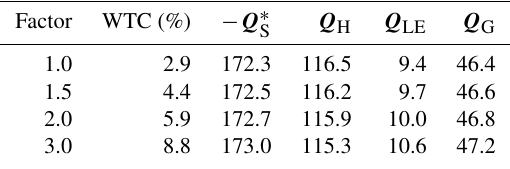
Table 3. Integrated energy fluxes from bare soil in lower Taylor Val- ley calculated with Eq. (10). “Factor” denotes different increments of water track coverage (WTC) relative to the observed value